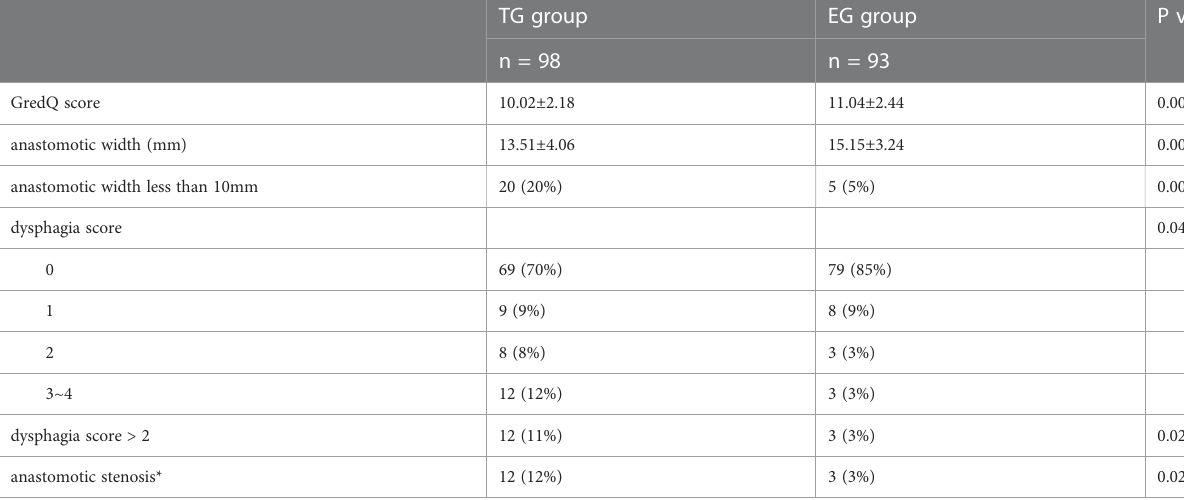
TABLE 4 Postoperative quality of life (3 months after surgery).